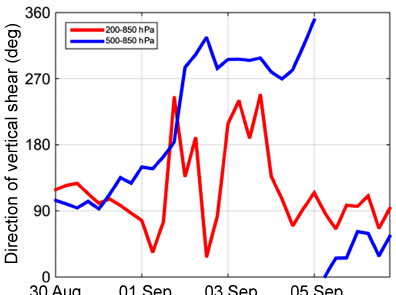
Figure 3. Direction of vertical wind shear. The direction of the wind shear is shown for the 200–850hPa (red line) and the 500– 850hPa (blue line) levels. The directions are compass directions in a meteorological sense. The 500–850hPa shear is mainly from the northwest on 2 September 2010. Analysis by RM12 showed that the source region for dry air was from north of the